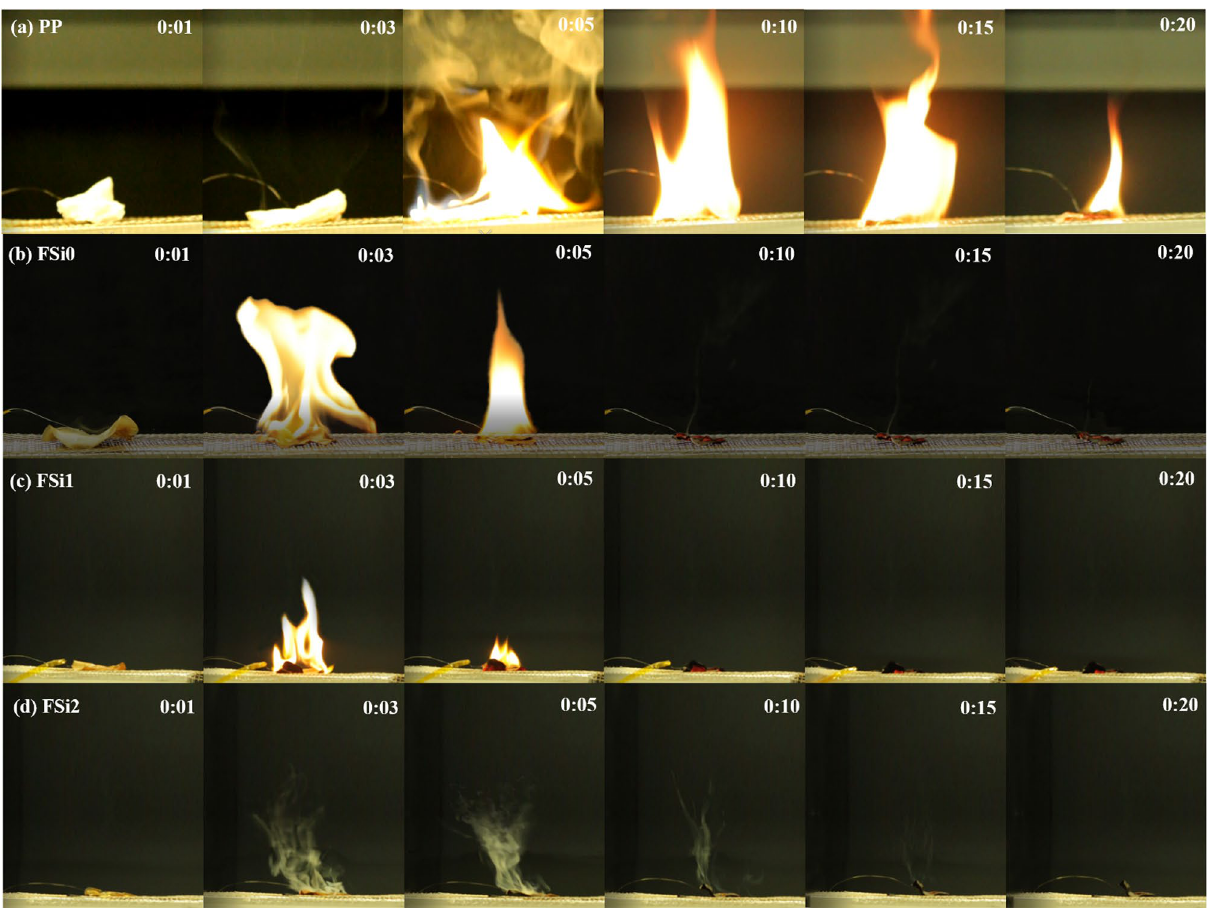
Figure 10. Video screenshots of representative samples ( a ) PP; ( b ) FSi0; ( c ) FSi1; ( d ) Ignition did not achieve in FSi2 during the heating ignition test.